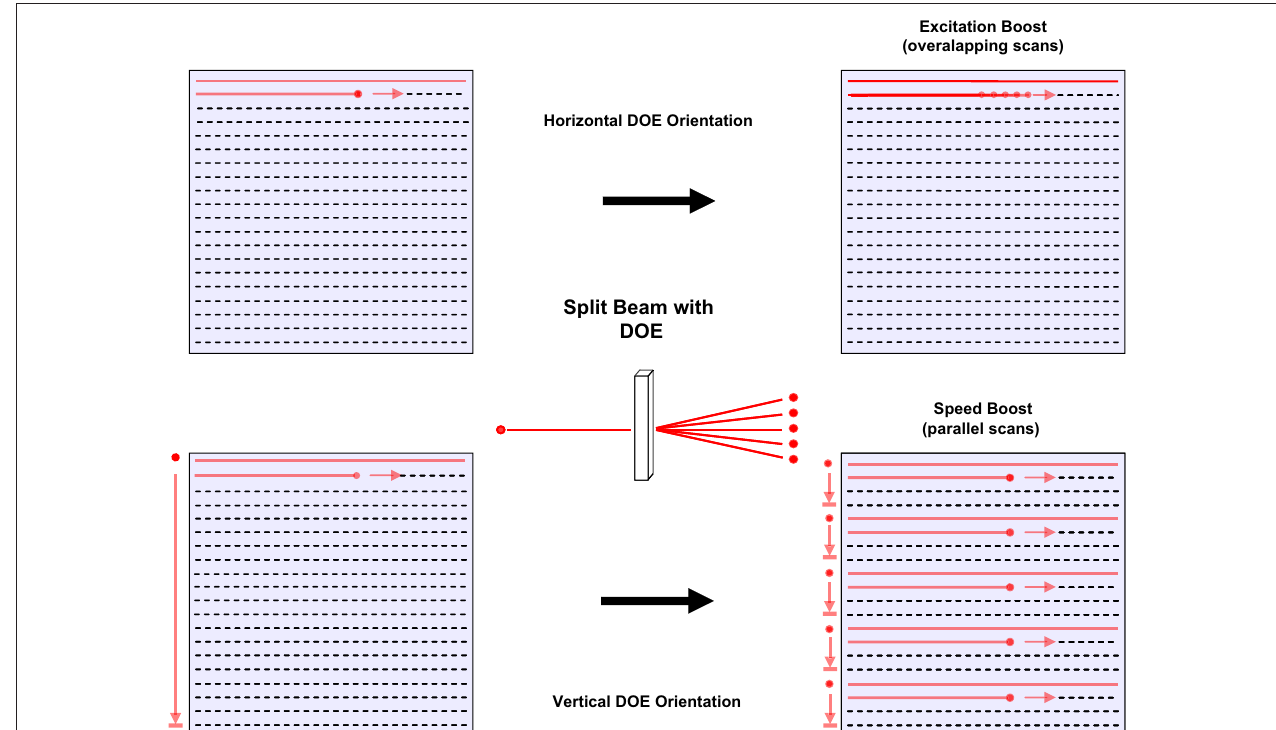
scanning. By spacing DOE-created beamlets widely over the vertical aspect of the fi eld of view and scanning each beamlet simultaneously horizontally across a narrow strip of the fi eld of view it is possible to excite the full fi eld of view in 1/(number of beamlets) the amount of time required for a single beam. As indicated by arrows at left of each representation of a fi eld of view, in the standard raster scan mode, a single beam must make horizontal line scans along the entire height of the fi eld (long arrow), whereas in speed boost, each beamlet simultaneously scans a fraction of the vertical aspect of the fi eld (short arrows). This method requires a camera or any other similar wide-fi eld light collection device (such as a photodiode array or multianode photomultiplier tube) with a resolution equal to at least the number of beamlets used, since more than one area is excited